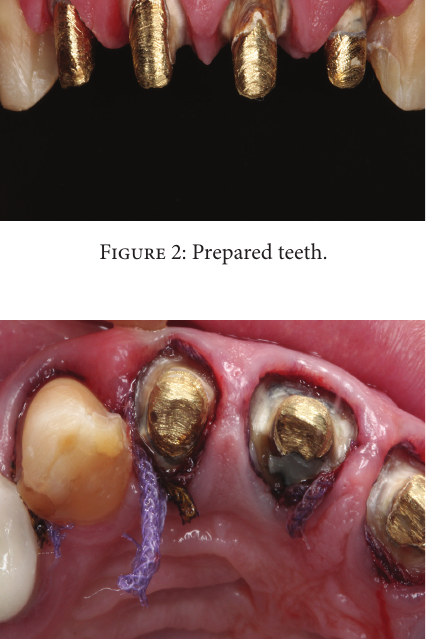
Figure 3: Gingival displacement with retraction cord. Note patient’s gingival biotype proper for this impression technique.